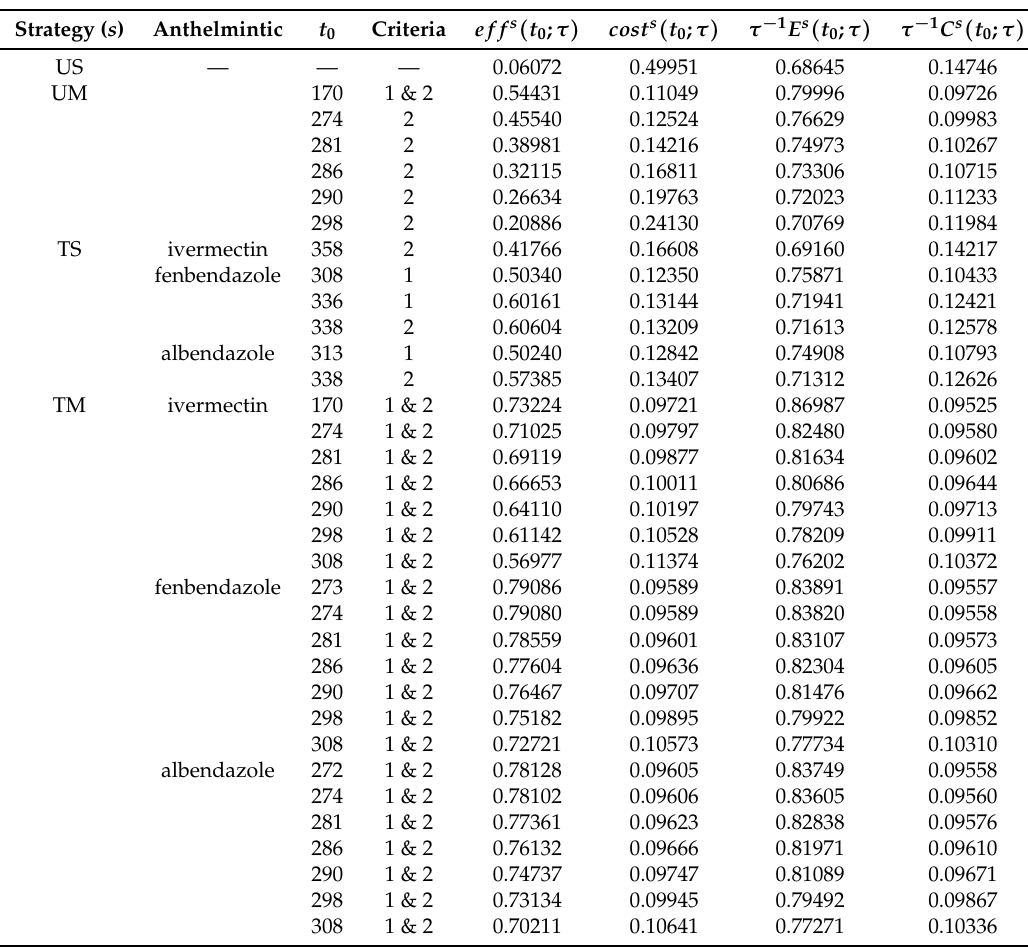
Table 1. Effectiveness and cost of intervention. Scenario US and grazing strategies UM, TS and TM with the anthelmintics ivermectin, fenbendazole and